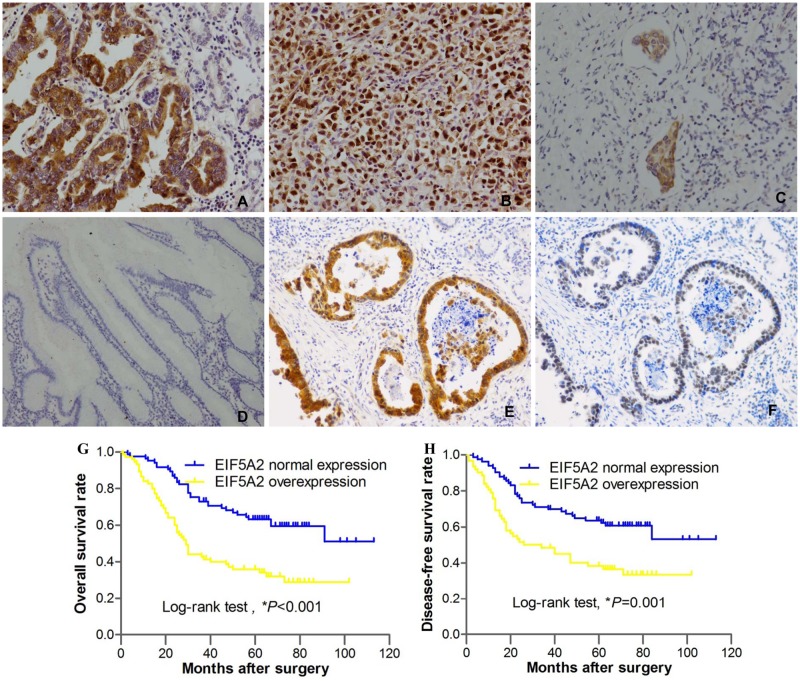
EIF5A2 Expression in human GC tissues and its prognostic significance.(A) Representative immunohistochemistry images showing EIF5A2 overexpression in moderately-differentiated adenocarcinoma (×200). (B) Overexpression of EIF5A2 in poorly-differentiated gastric adenocarcinoma (×200). (C) Overexpression of EIF5A2 in tumor cells invading vessels (×200). (D) Normal expression of EIF5A2 in non-tumor tissue (×100). (E) The typical staining images showing both EIF5A2 and MTA1 overexpression in the same gastric adenocarcinoma; (G) Overall survival curves for 160 gastric cancer patients receiving gastrectomy, grouped according to EIF5A2 expression (P<0.001). (H) Disease-free survival curves for 145 gastric cancer patients receiving curative surgery, grouped according to EIF5A2 expression (P = 0.001).